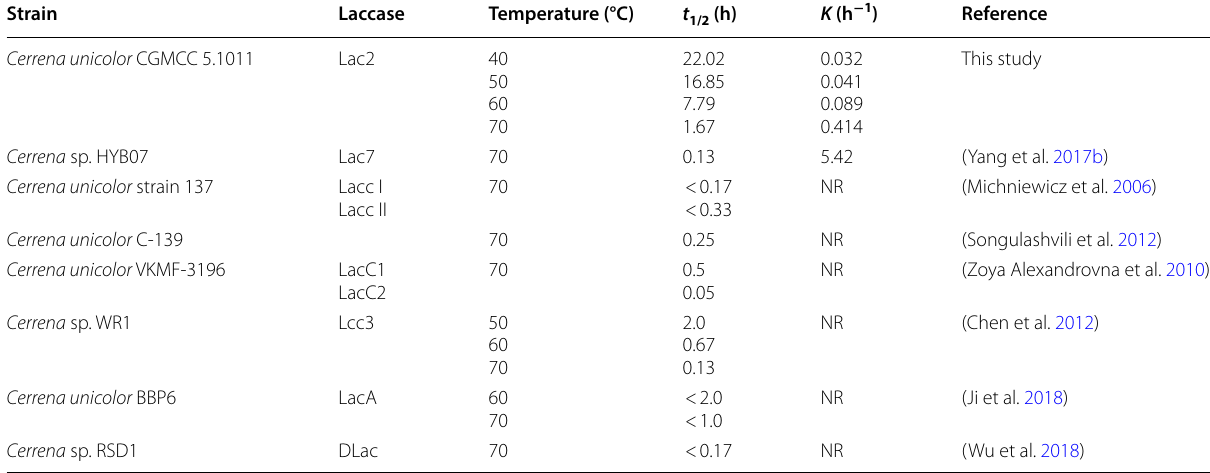
ABTS was used as the substrate